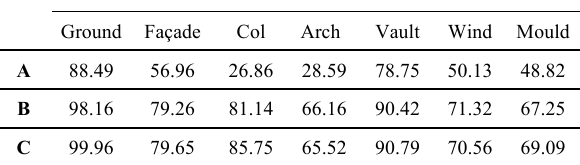
Table 4. Per-class F1 scores for the Dublin dataset.